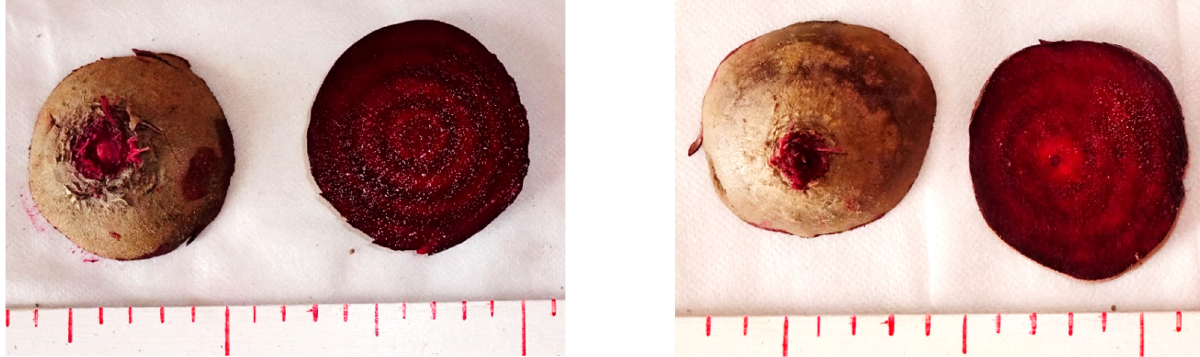
Figure 7. The size of the table beetroot neck and the intensity of the color (( left ): 3 cm; ( right ): 1.5 cm).